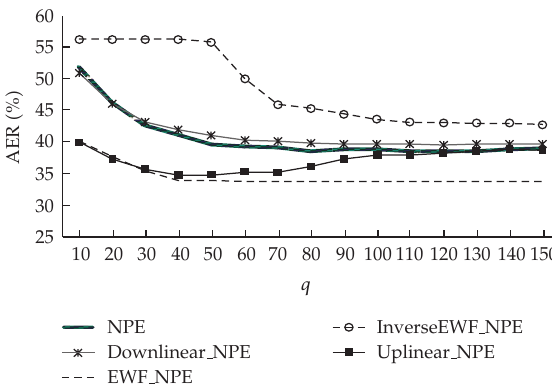
Figure 10: Recognition error rates of NPE, EWF NPE, Uplinear NPE, Downlinear NPE and Inverse- EWF NPE.